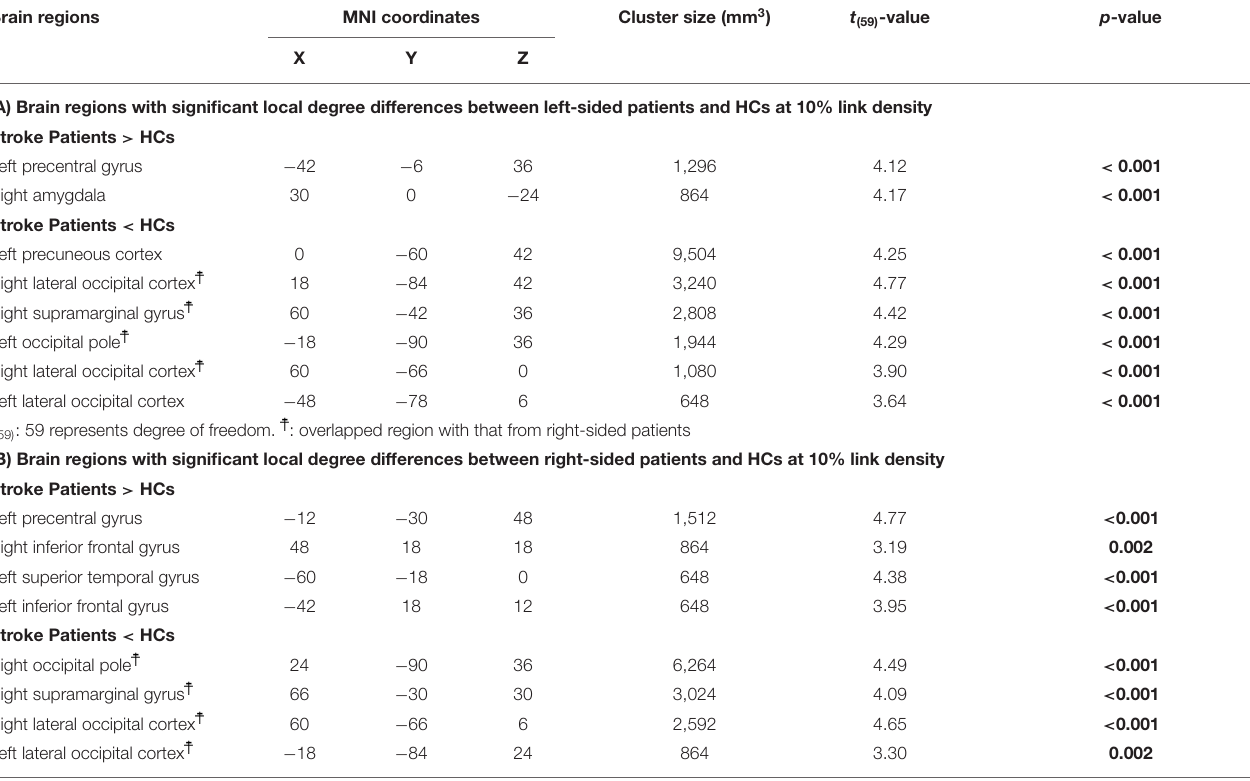
Stroke Patients > HCs